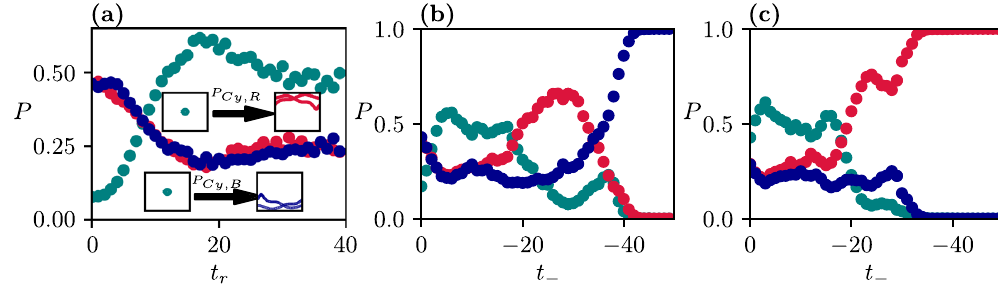
Figure 5. ( a ) Dependence of the tipping probabilities on t r for t − = 0, C − = 0.1, C + = 0.5835 ( I 2 ) and t + = 100 (in order to avoid transient-reduced tipping discussed in the previous section), with a visual illustration of the change in the character of the attractors due to the tipping transitions (insets). ( b ) and ( c ) Dependence of the tipping probabilities on the starting time t − with t r = 5 in ( b ) and t r = 10 in ( c ). Since the tipping probabilities are heavily dependent on both t r and t − , we get a more complete view by showing this bivariate function in Supplemental Discussion III.